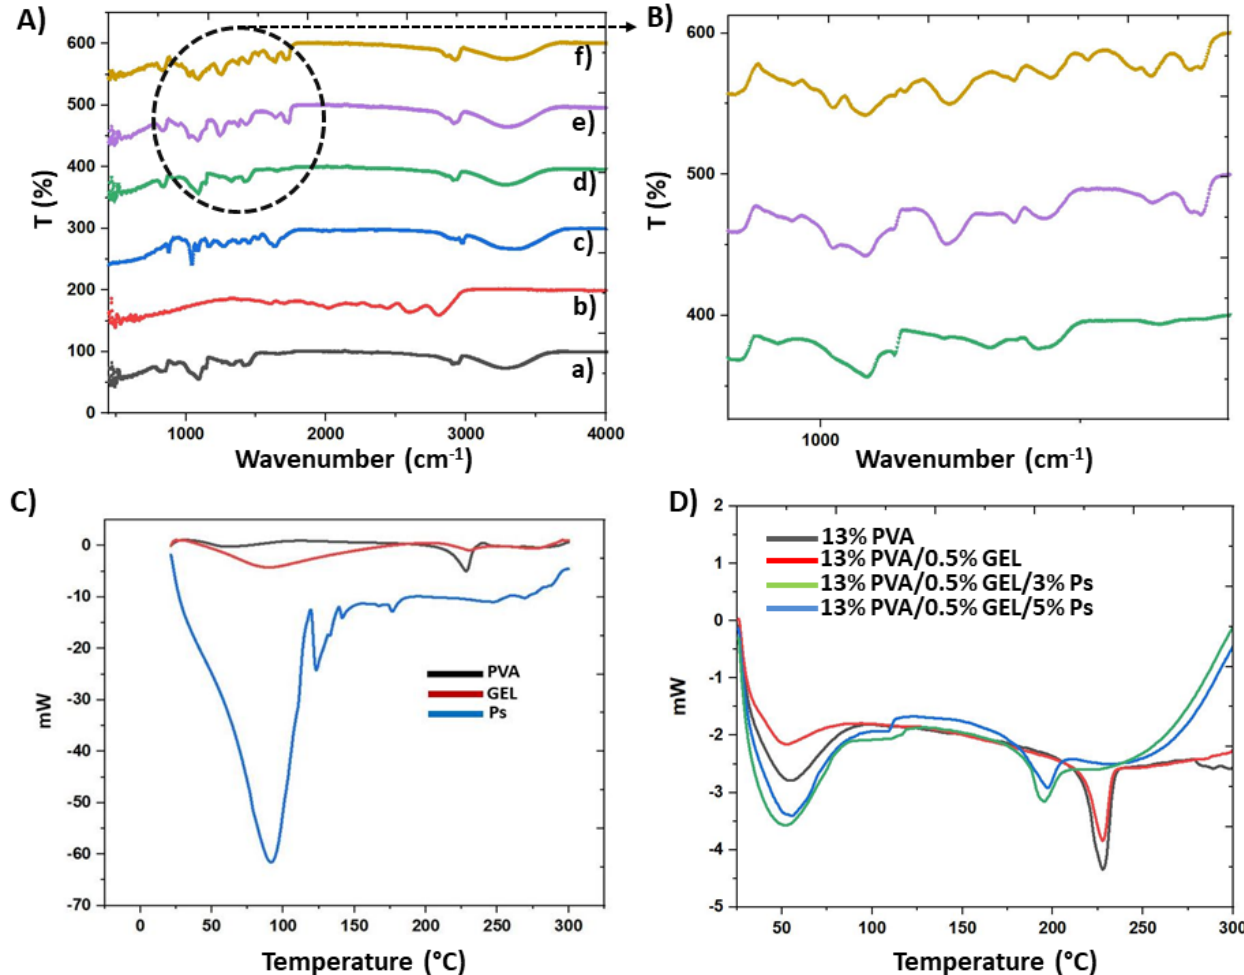
Figure 3. The labels ( A , B ) represented the FTIR spectrums: 13% PVA (a), pure GEL (b) and Propolis (c), 13% PVA/0.5% GEL (d), 13% PVA/0.5% GEL/3% Ps (e), 13% PVA/0.5% GEL/5% Ps (f). ( C , D ) showed the DSC curves of the pristine PVA, GEL, Ps and prepared corneal patches.